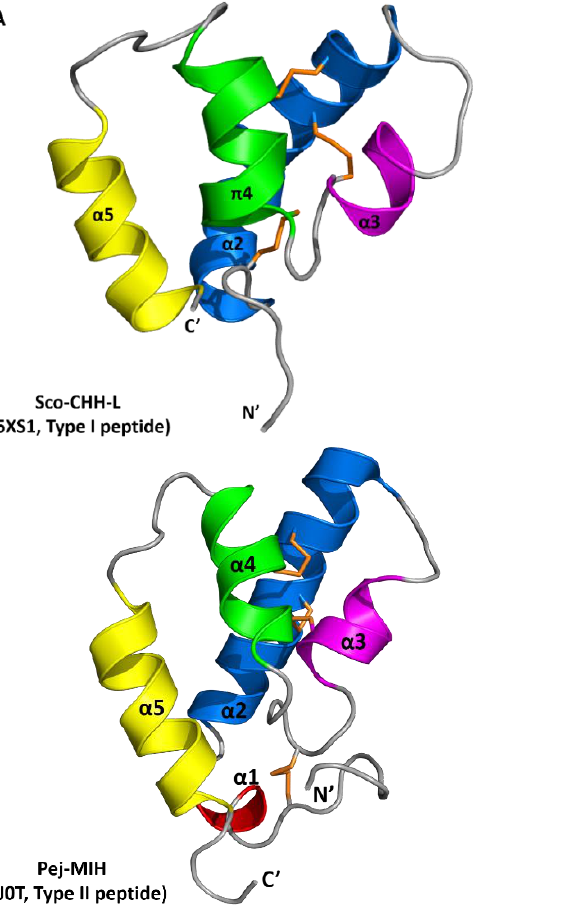
Figure 2. Structure of Sco-CHH-L and its comparison with other CHH/ITP peptides. ( A ) Ribbon and ( B ) surface structure of Sco-CHH-L, and ribbon structure of ( C ) Pej-MIH and ( D ) Pej-SGP-I-Gly. The helices, N - and C -terminus (N′ and C′) are labeled. ( B ) Location of the ten residues that were alanine-substituted in the Sco-CHH-L mutants are labeled on the surface structure. Note that ( B ) is not viewed from the same angle as ( A ), but is rotated so that all residues are visible. ( A , C , D ) Orange sticks indicate disulfide bridging.